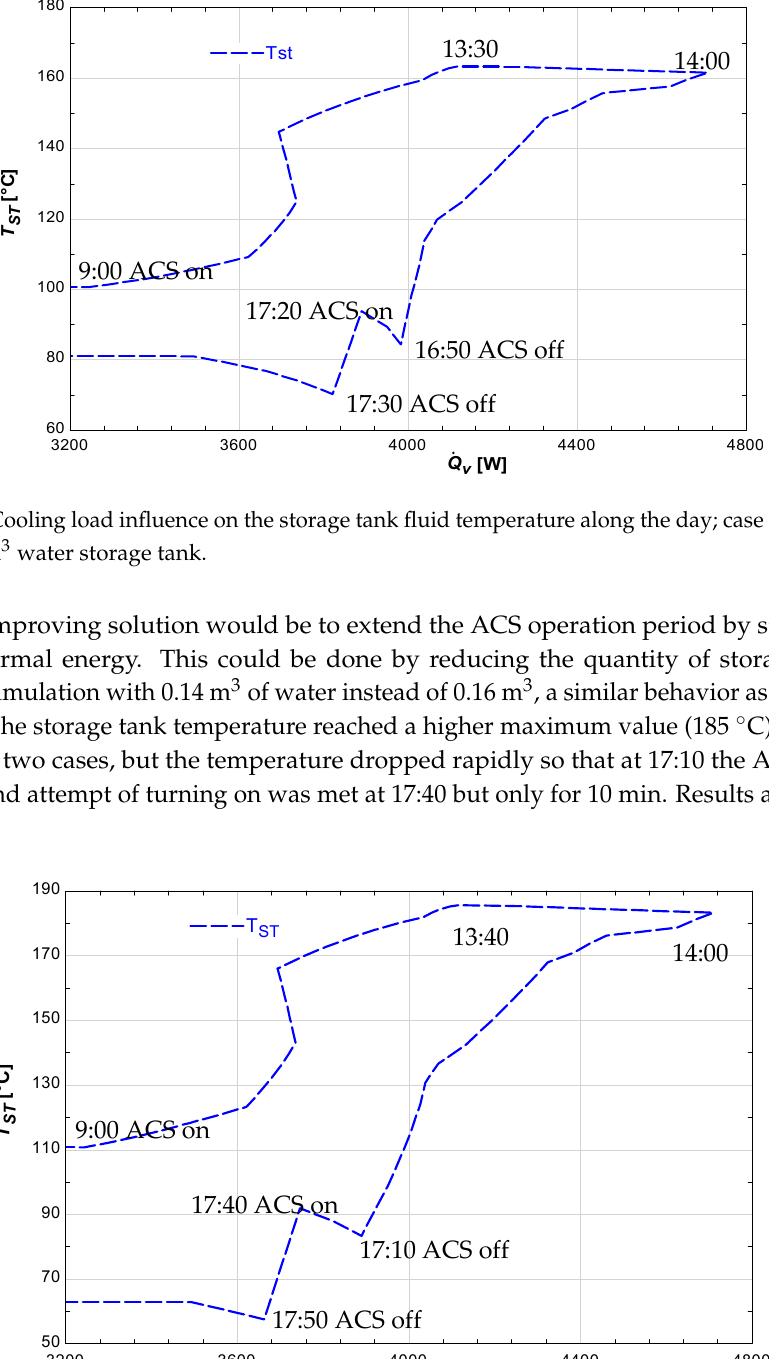
Figure 12. Cooling load influence on the storage tank fluid temperature along the day; case study 10 m PTC, 0.14 m 3 water storage tank.